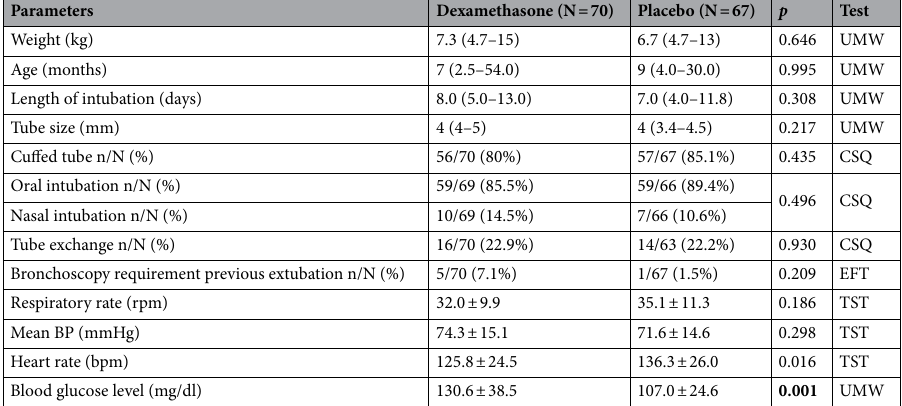
Dexamethasone (N = 70) Placebo (N = 67) p Test